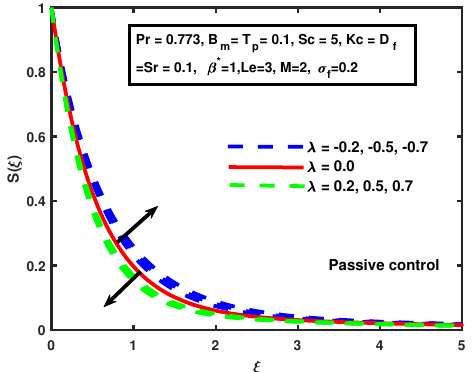
Figure 13. The impact of S ( ξ ) on suction/injection λ (passive control case).